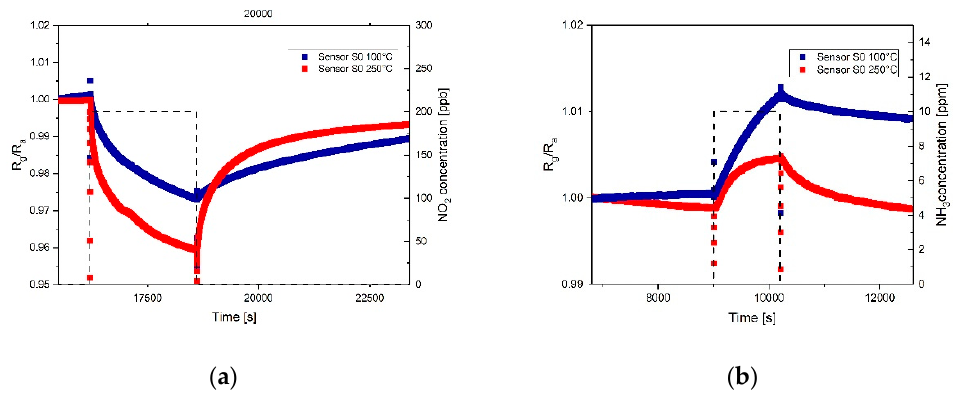
Figure 14. ( a ) Response of the sensors S 0 towards 200 ppb of NO 2 . The red curve shows the response of the sensor during measurements at 250 ◦ C; the blue curve shows the response of the sensor during measurements at 100 ◦ C; ( b ) Response of the sensors S 0 towards 10 ppm of NH 3 . The red curve shows the response of the sensor during measurements at 250 ◦ C; the blue curve shows the response of the sensor during measurements at 100 ◦